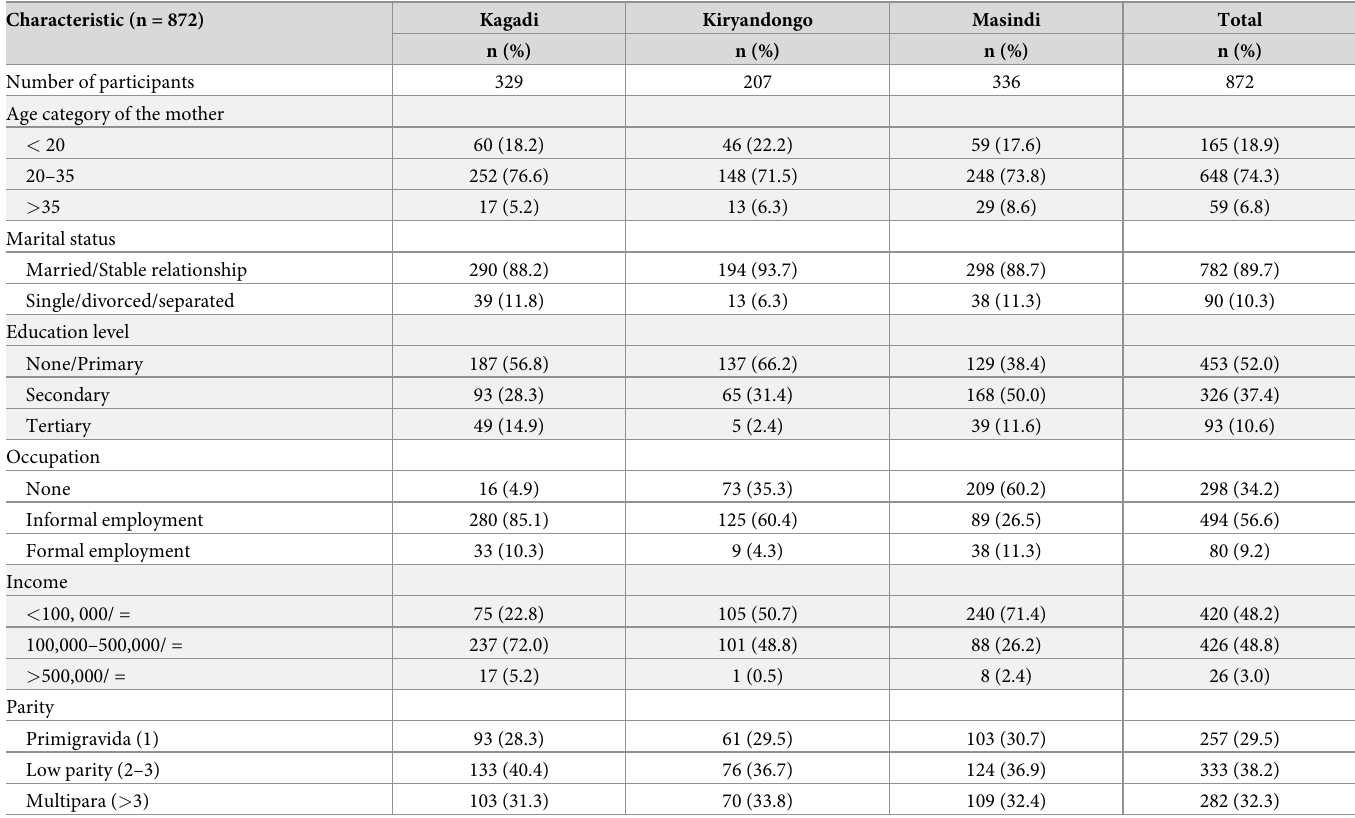
Table 1. Characteristics of the study